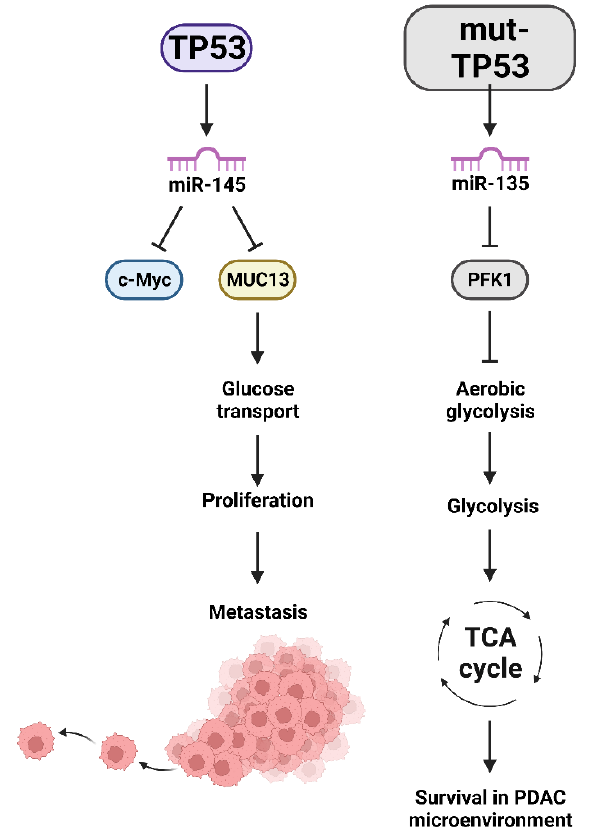
Figure 4. Effects of miRs induced by TP53 which have Effects on Glucose Transport, Aerobic Gly- colysis, TCA Cycle, Survival in the Hypoxic PDAC Microenvironment and Metastasis. v-Myc avian myelocytomatosis viral oncogene homolog (c-Myc), mucin 13 (MUC13), PFK1 = phosphofructokinase-1 (PFK1), tricarboxylic acid cycle (TCA).